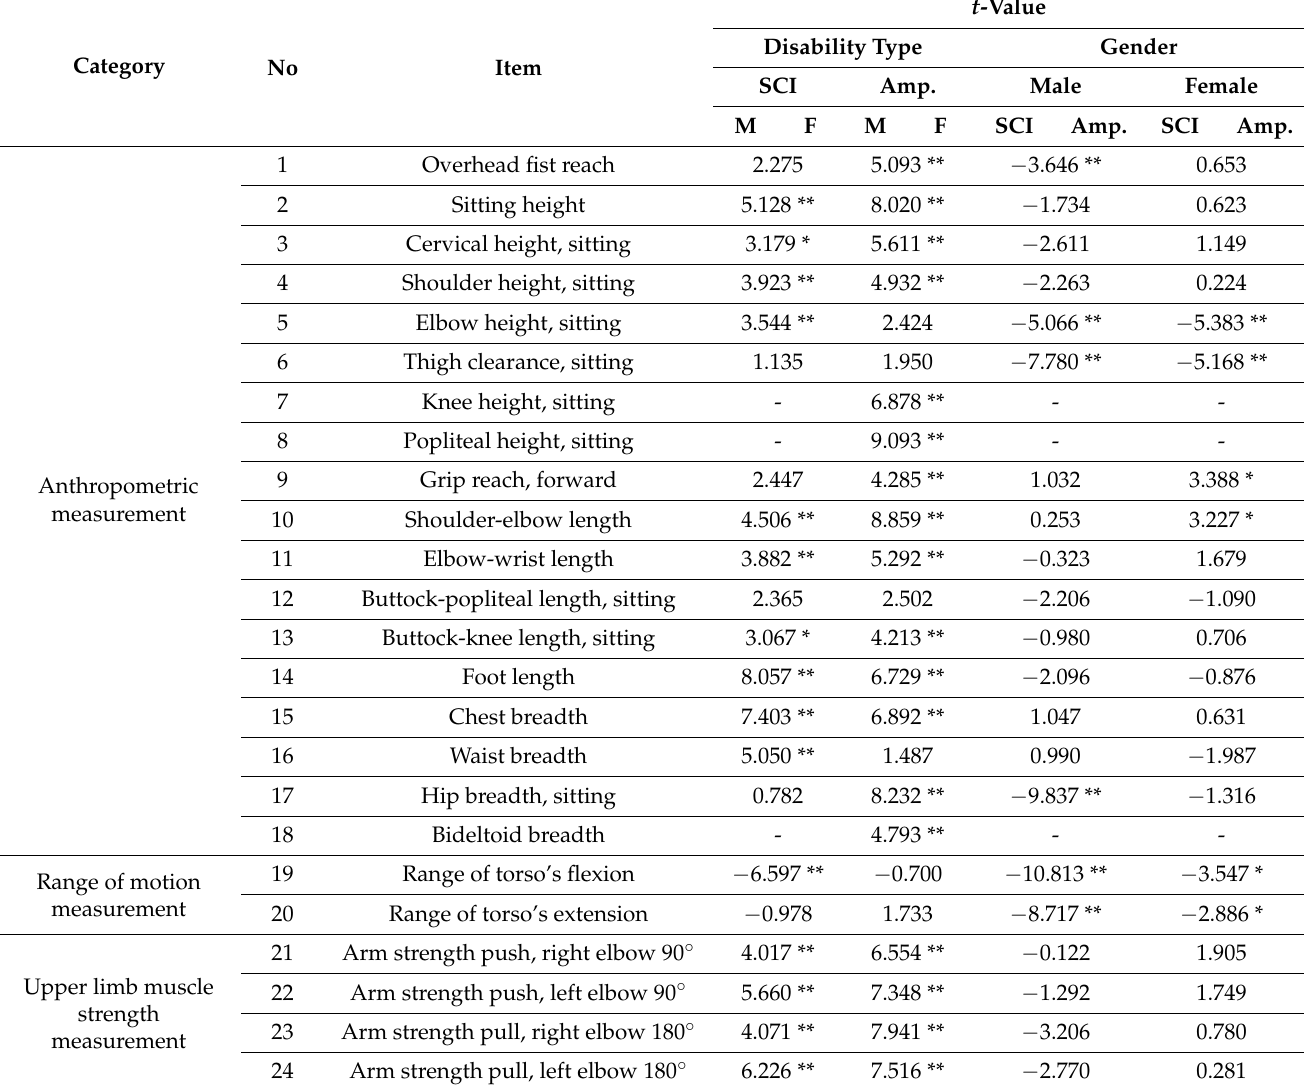
Table 6. Statistical analysis of independent t -test by disability type and